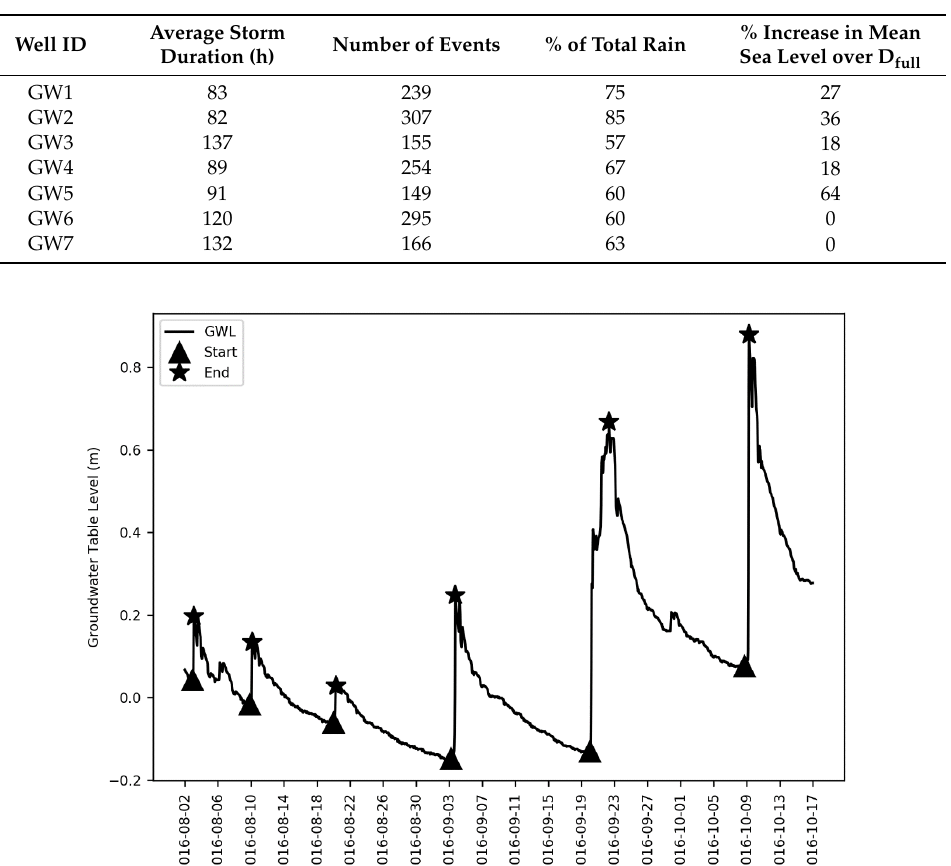
Figure 6. Detail of identified storm periods found for well GW1.